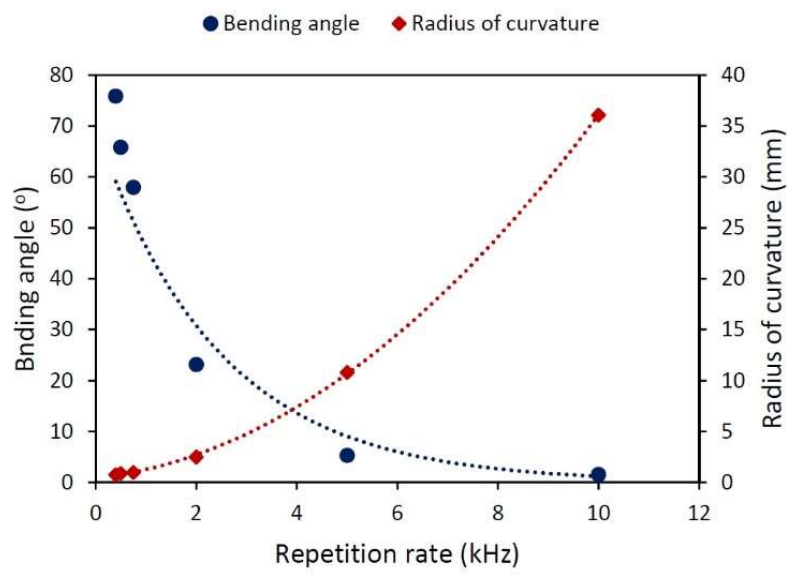
Figure 7. Bending angle (round points) and radius of curvature (diamonds) dependence on repeti- rate ranging from 0.4 to 10 kHz. Scanning speed ranging accordingly from 0.4 to 10 mm tion rate ranging from 0.4 to 10 kHz . Scanning speed ranging accordingly from 0.4 to 10 with a length of 1 mm, P y = 20 µ m, P x = 1 µ m, and E = 115 µ J. The lines are visual Treated area with a length of 1 mm , P (cid:2935) = 20 μm , P (cid:2934) = 1 μm , and E = 115 μJ . The lines are visual guides.